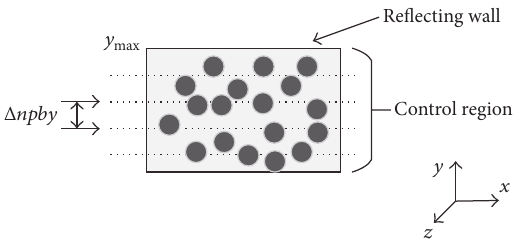
Figure 5: Detailed schematic of the npbf region residing in the control